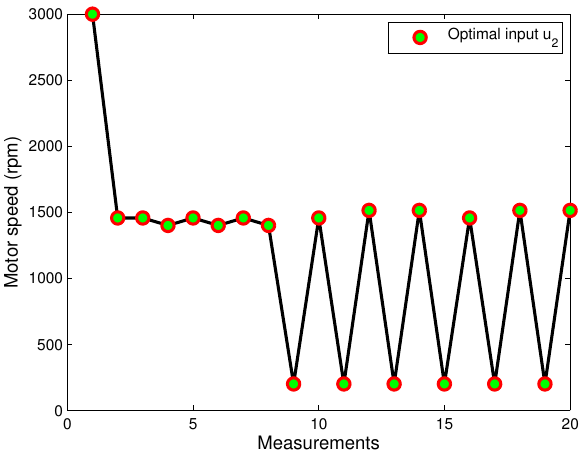
Figure 8. Additional dedicated data samples selected for input u 2 .